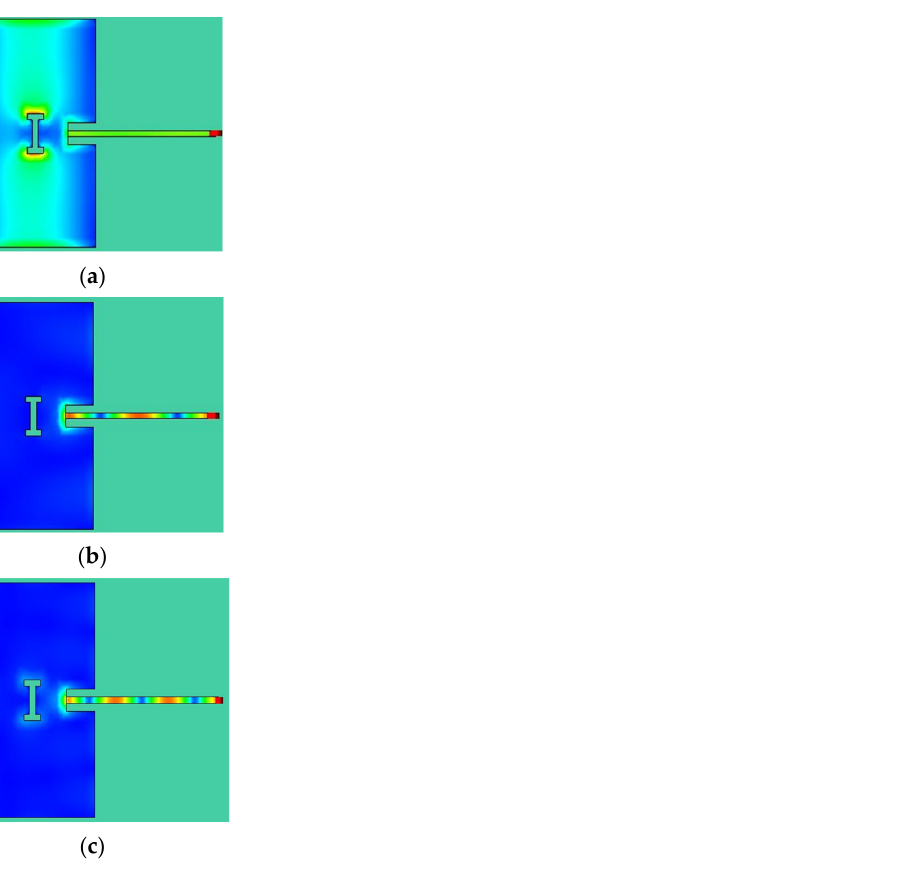
Figure 4. Antenna gain pattern (simulation).